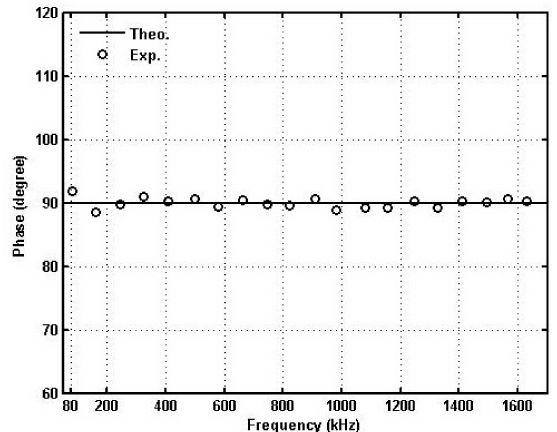
Figure 25. The measured phase difference of quadrature output voltages V o1 and V o2 versus the tuning FO.